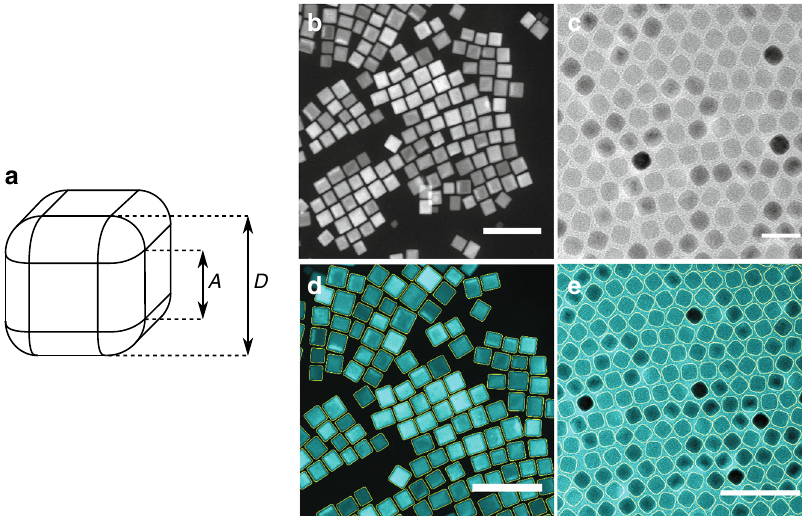
Fig. 1 The shape of building blocks. a A schematic illustration of the NP shape, b HAADF-STEM image of sharp Fe 3 O 4 nanocubes, and c TEM image of rounded Fe x O/CoFe 2 O 4 nanocubes, d EM image of nanocube cores (cyan) with the fi tted shape (yellow) for the sharp Fe 3 O 4 nanocubes and e same as in d but for the rounded Fe x O/CoFe 2 O 4 nanocubes. Scale bars, b 100 nm, c 20 nm, d 100 nm, e 50